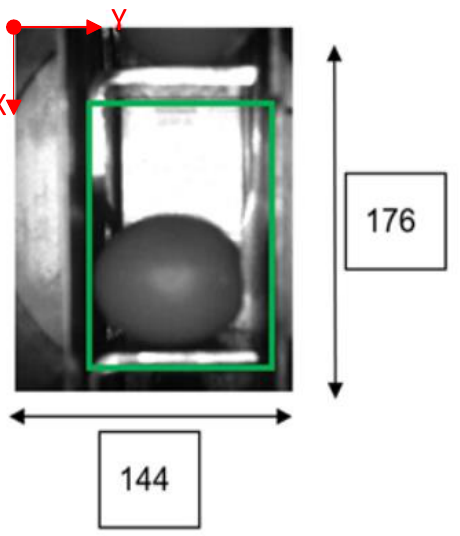
Figure 1. Example of the use of region of interest (ROI) in an olive in a normal position. The red point corresponds to the origin of coordinates for pixels. The green rectangle comprises the pocket within its walls and depth and limited by the previous and the next pocket of the feed chain. The red rectangle is the ROI.